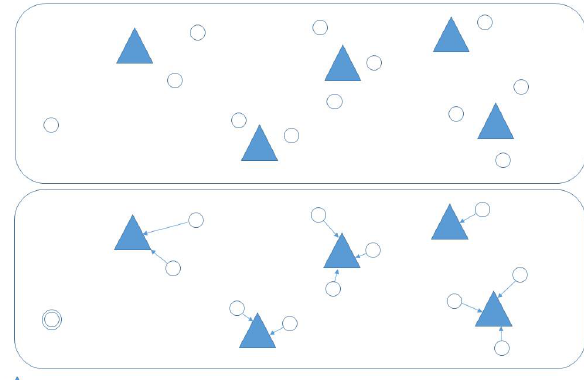
Figure 5. Linking of sensors to air quality monitoring stations based on